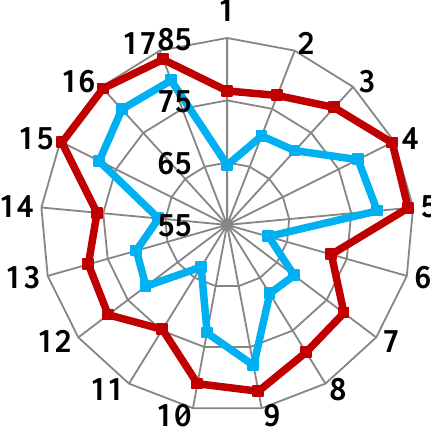
Fig. 1 Expected life span of population, determined from birth, by sex, years [22]: – man; – women; 1 – Byelorussia; 2 – Bulgaria; 3 – Estonia; 4 – Spain; 5 – Italy; 6 – Kazakhstan; 7 – Latvia; 8 – Lithuania; 9 –Germany; 10 – Poland; 11 – Russia; 12 – Slovakia; 13 – Hungary; 14 – Ukraine; 15 – France; 16 – Switzerland; 17 –